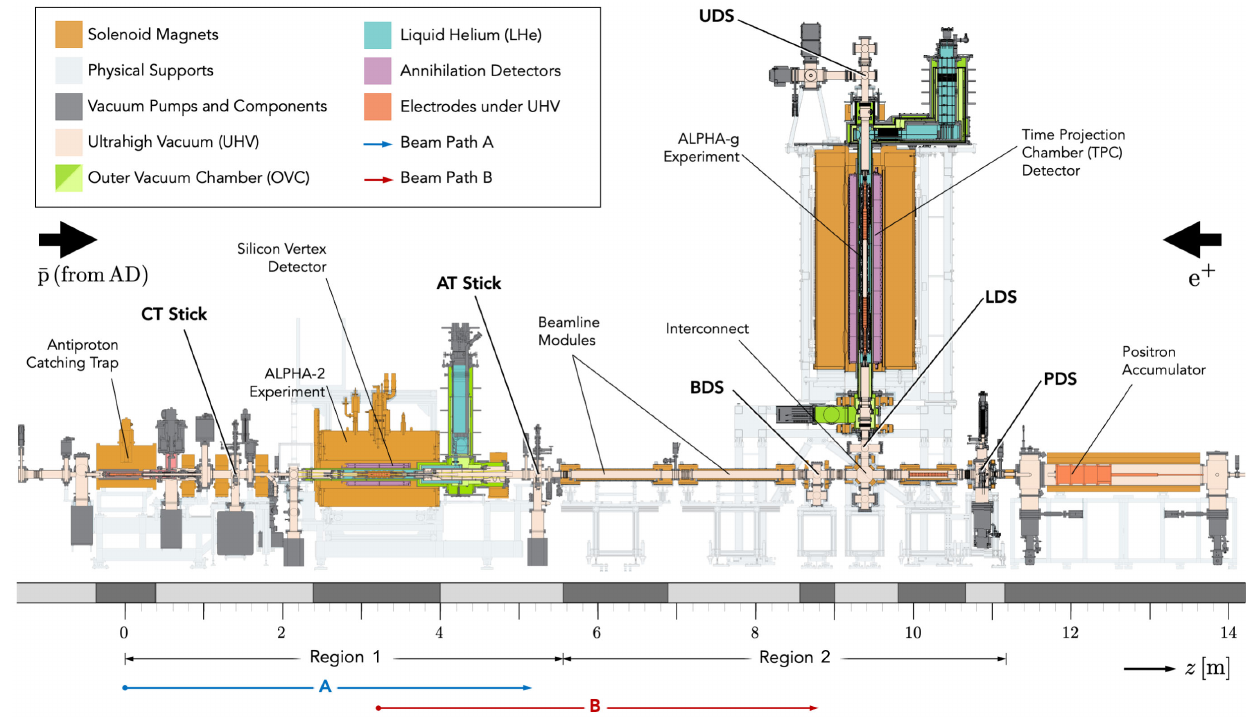
FIG. 1. Schematic showing a cross-section view of the ALPHA apparatus following the installation of the ALPHA-g experiment and new beamline in 2018. The horizontal axis is shaded to differentiate between individual sections of the apparatus. Smaller detectors (e.g. scintillator panels) are not shown for clarity. The locations of beam diagnostics are annotated in bold. See text for further